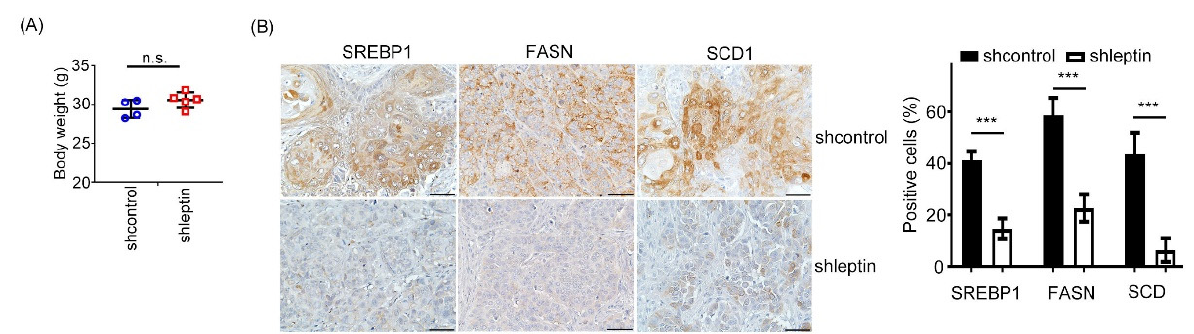
Figure 5. Leptin inhibition attenuates SREBP1 expression in vivo. ( A ) Mouse body weights were measured in shcontrol and shleptin groups. ( B ) IHC was performed to investigate the protein expression levels of SREBP1, FASN, and SCD1 in shcontrol and shleptin xenograft tumors. The quantifications of IHC staining are shown. The data are presented as the mean ± SD. ***: p < 0.001; n.s.: not significant.